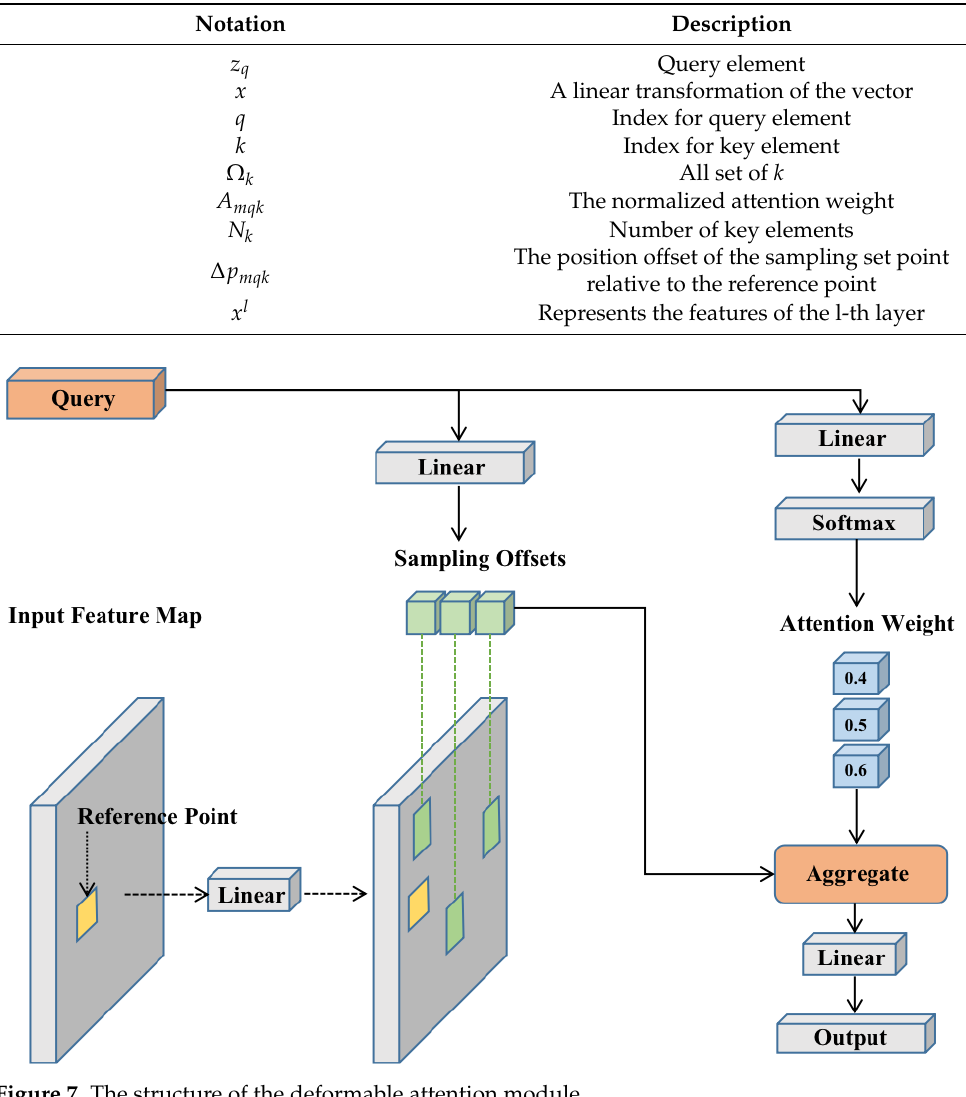
Table 1. The table for notation.